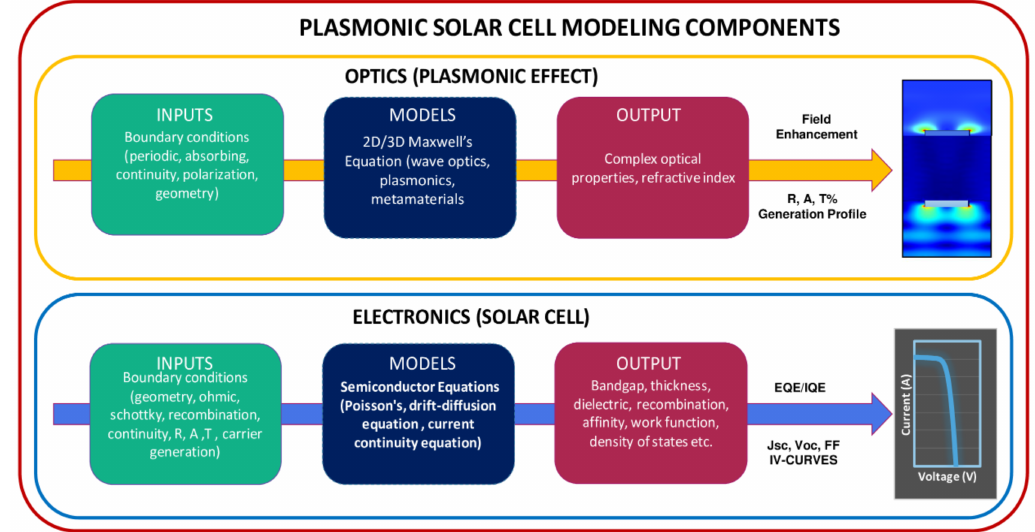
Figure 16. Plasmonic solar cell modeling components with respective input parameters, models, and output parameters required for device simulation.